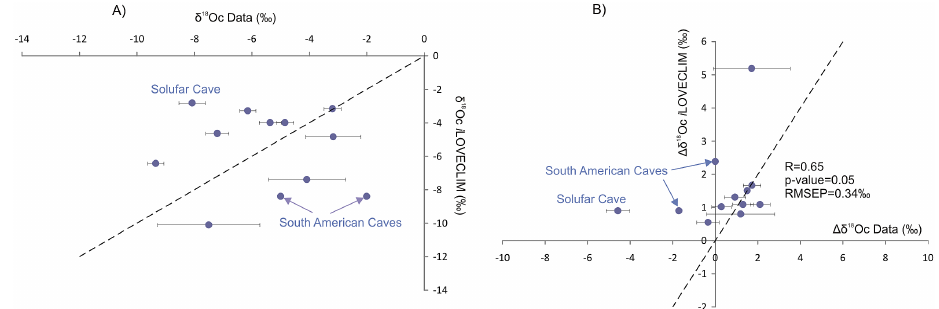
(Table 1). (b) Comparison between simulated continental calcite δ 18 O anomaly (LGM-CT) in i LOVECLIM and global speleothem data (Table 1). Reported uncertainties on data are 2 σ . The quantification of model–data agreement ( R =0.65; p value = 0.05; RMSEP = 0.34‰) is based on nine records (Solufar, Rio Grande do Norte and Santana Cave records were excluded).